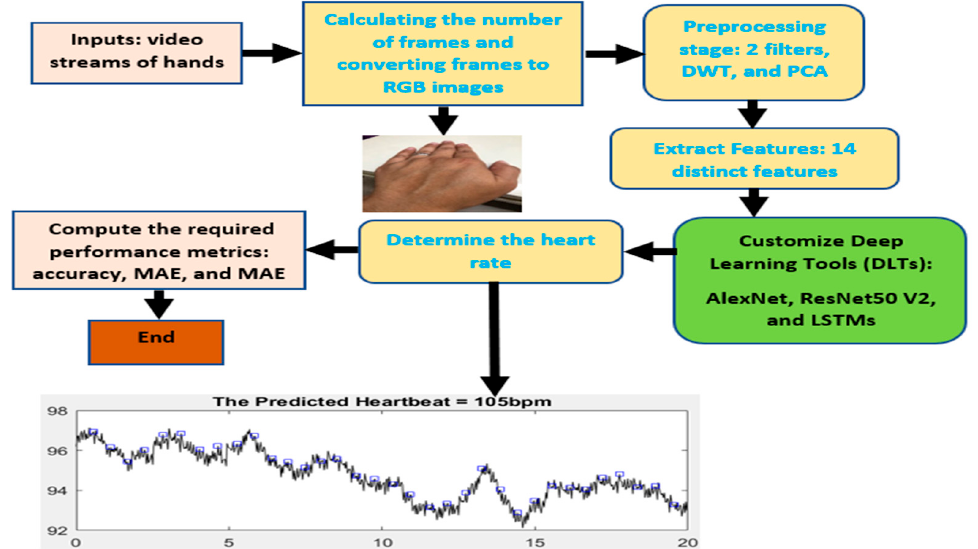
Figure 2. The flowchart of the proposed technique.